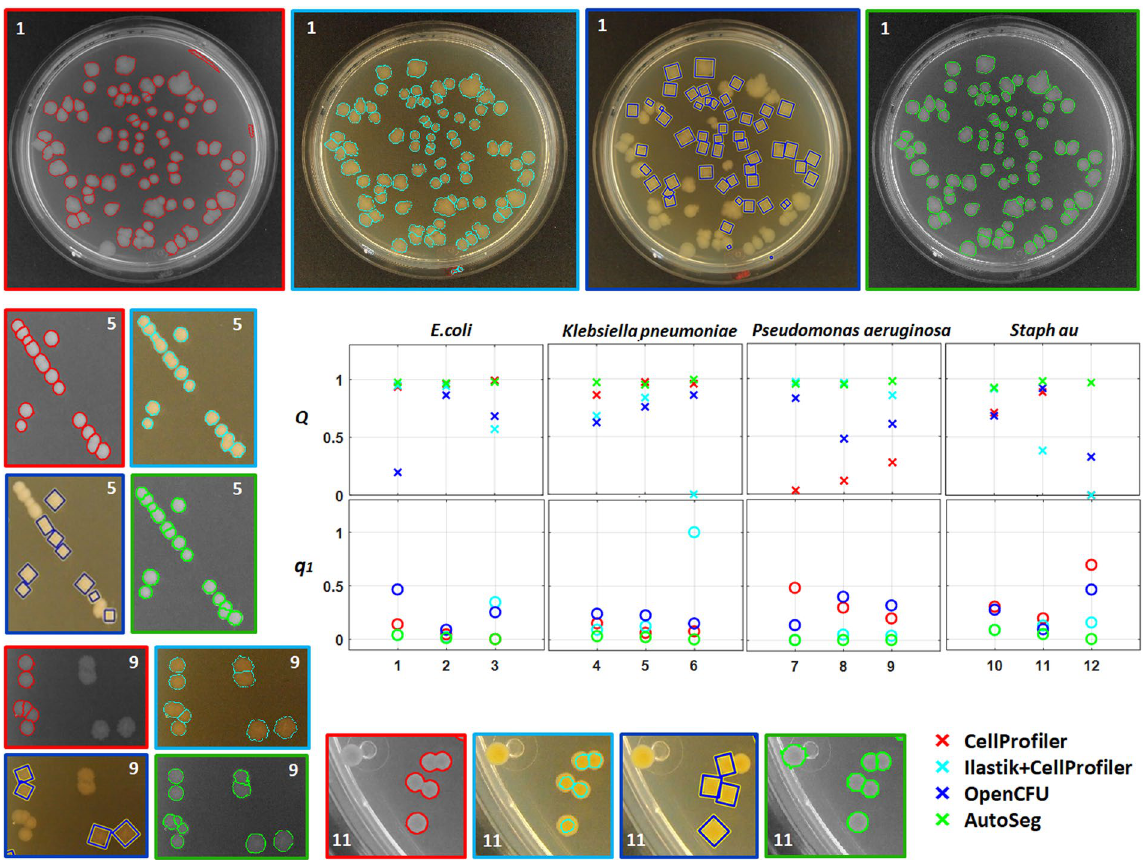
Figure 2. Results of the methods used on the new benchmark: CellProfiler (red), Ilastik + CellProfiler (cyan), OpenCFU (blue) and AutoCellSeg (green). One image from each species is selected (indicated by the image number on the image corners) to demonstrate the comparison. The graphs show segmentation/counting ( Q on y-axis of first row) and deviation from manual count ( q 1 on y-axis of second row) for all methods used based on the complete benchmark (on x-axis). Q incorporates the measures for both size and count of